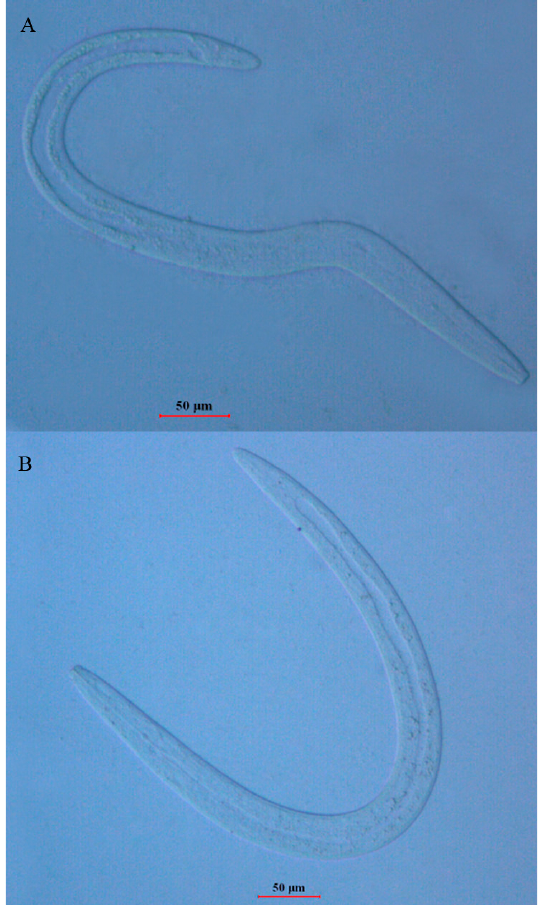
Figure 2. The phenotype of B. xylophilus after soaking in Bxpel1 double-stranded RNA (dsRNA) for 48 h ( A , B ). Scale bars = 50 μ m.